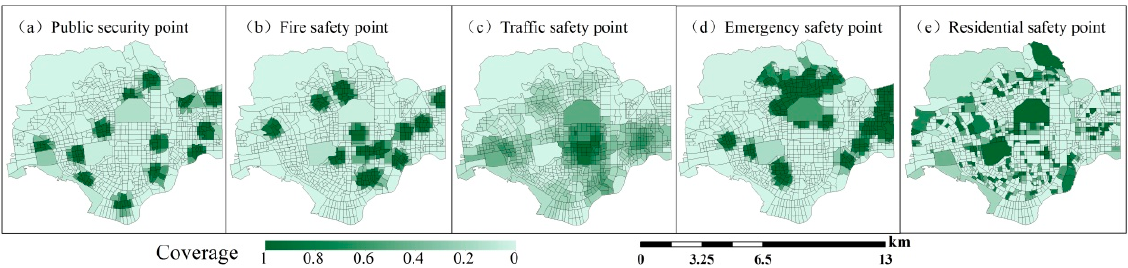
Figure 7. Infrastructure distribution.